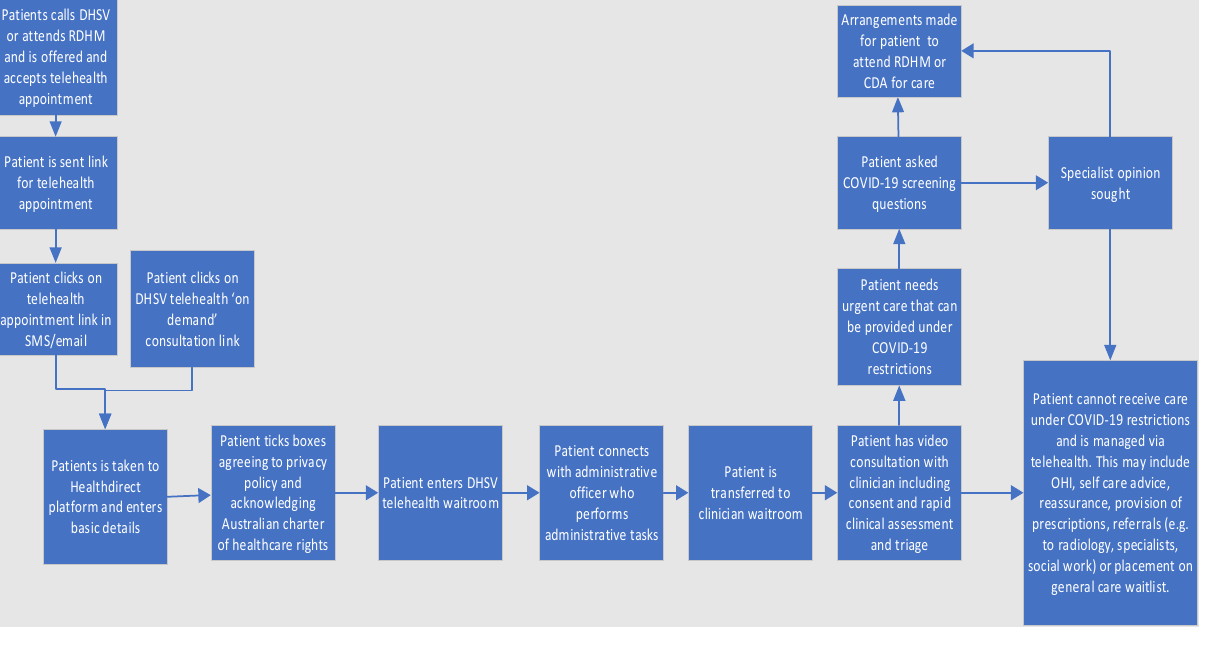
Figure 1. DHSV’s patient-initiated Teledentistry model of care.